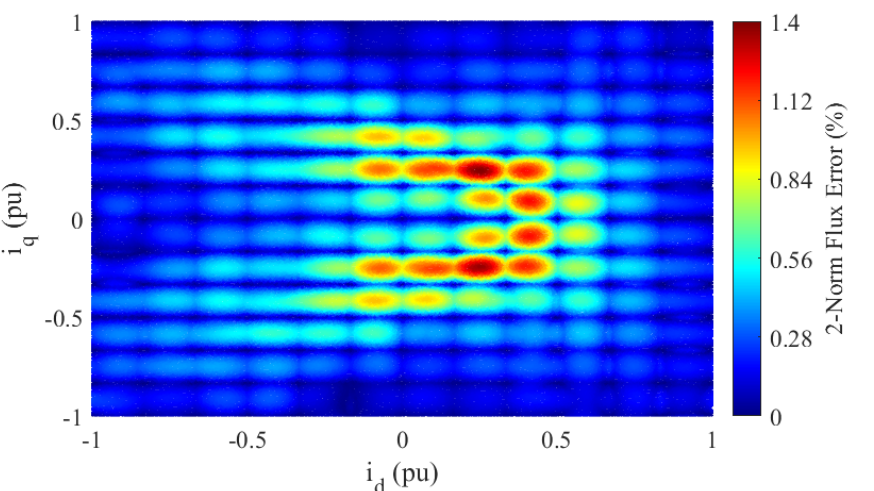
Figure 8. Two-norm flux error distribution between f PWA ( i ) and f S ( i ) , f PWA ( i ) constructed using